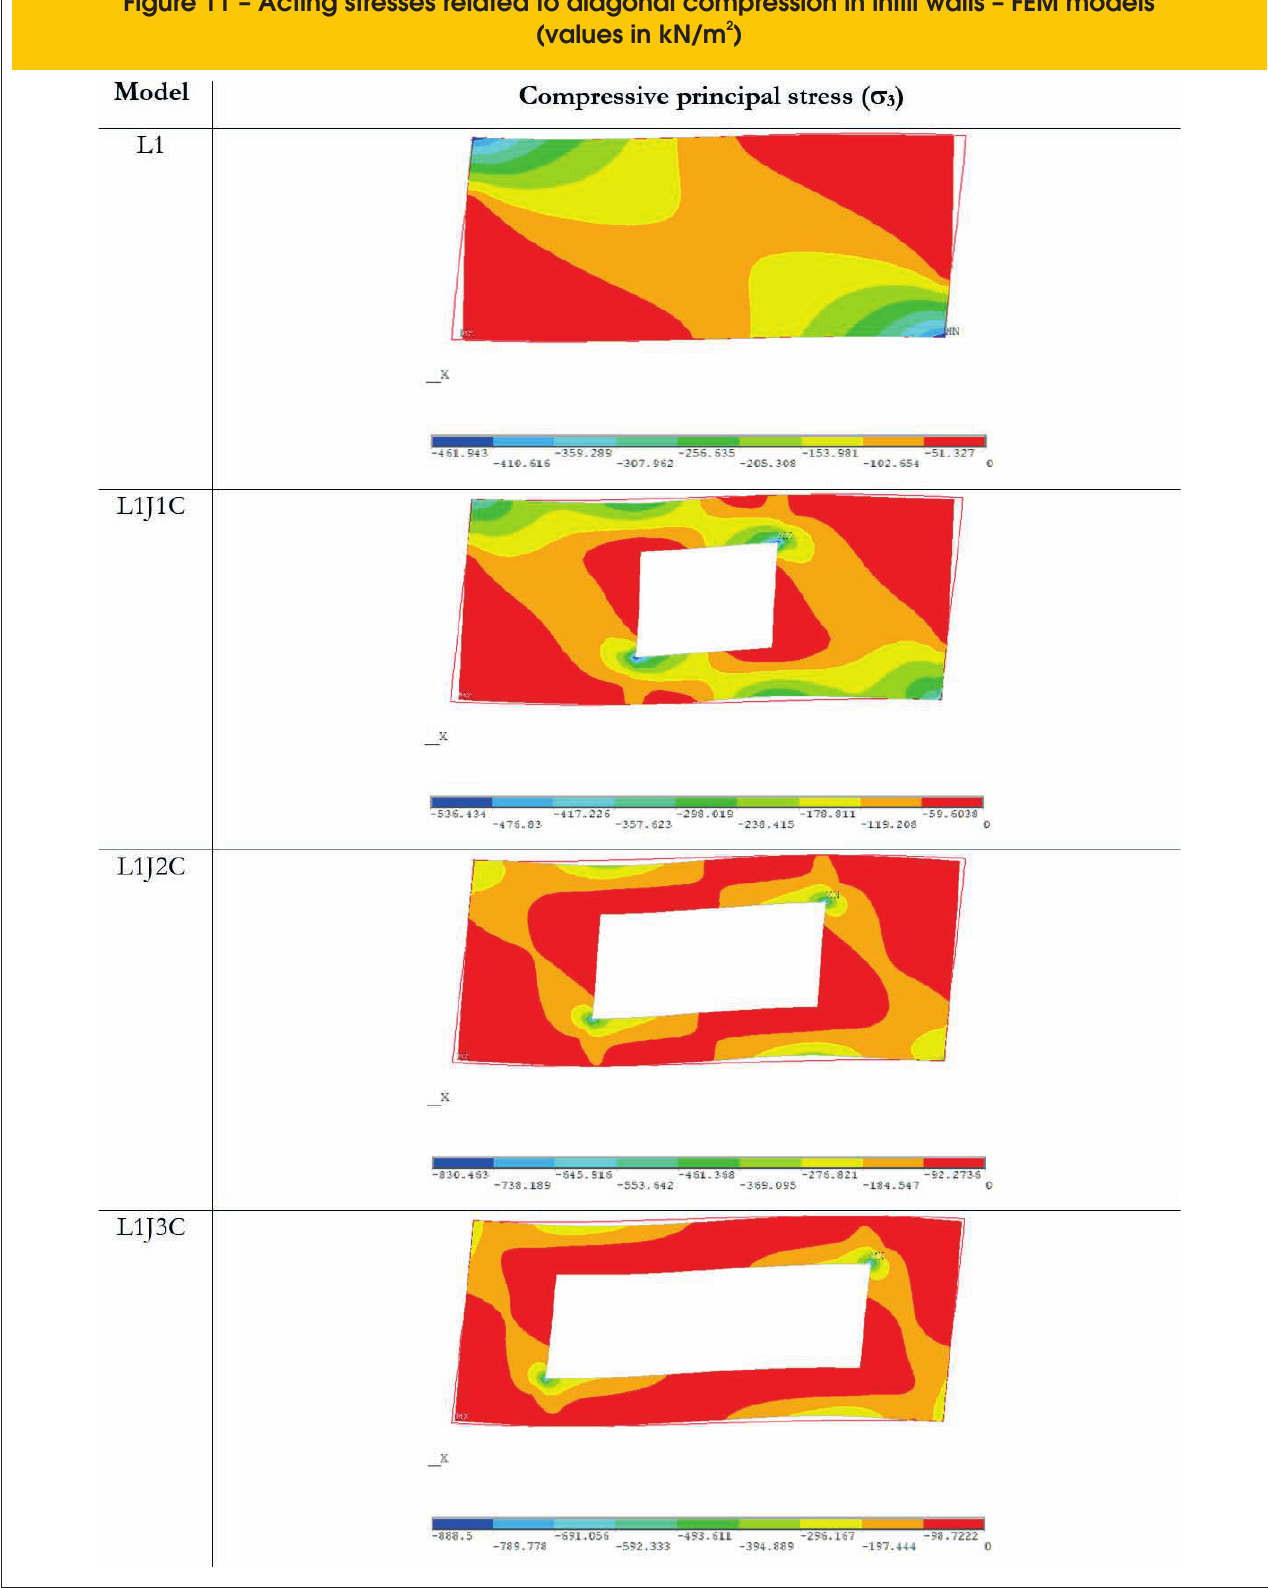
Figure 11 – Acting stresses related to diagonal compression in infill walls – FEM models